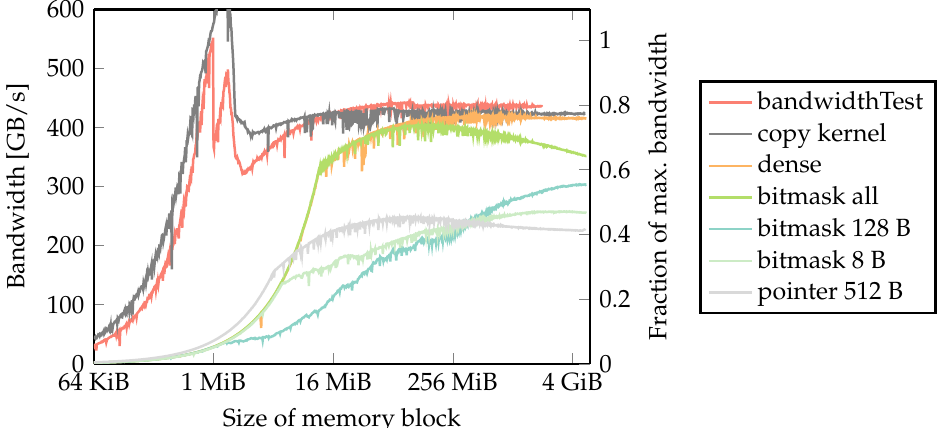
Figure 5. Bandwidth comparison of the simple CUDA copy kernel, bandwidthTest utility, and Taichi kernels copying linear memory. Numbers after “bitmask” and “pointer” denote the size of the data block assigned to a single